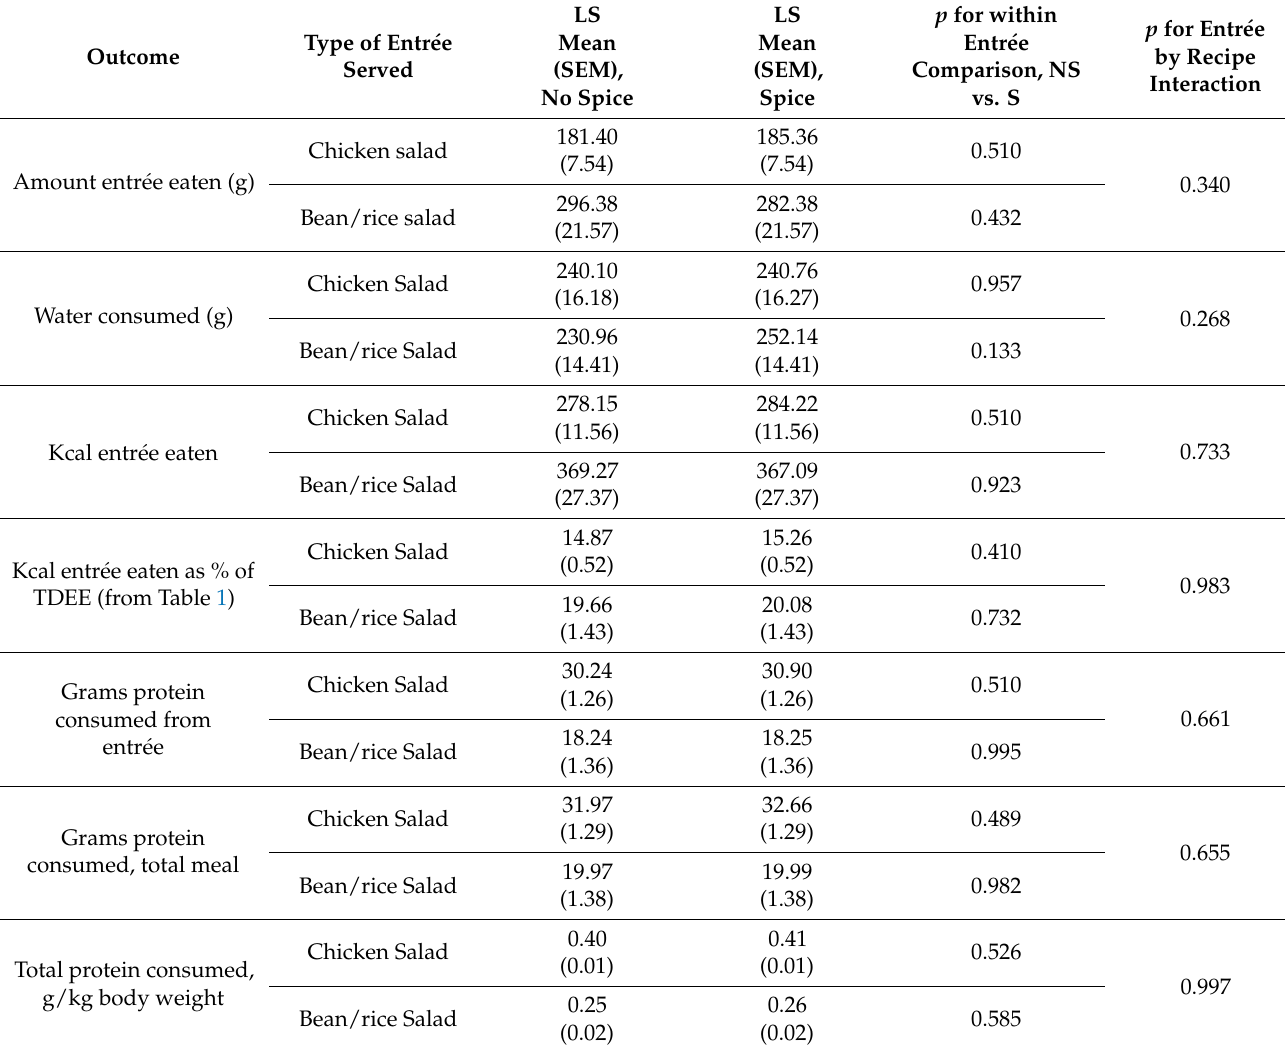
Table 2. Food and protein